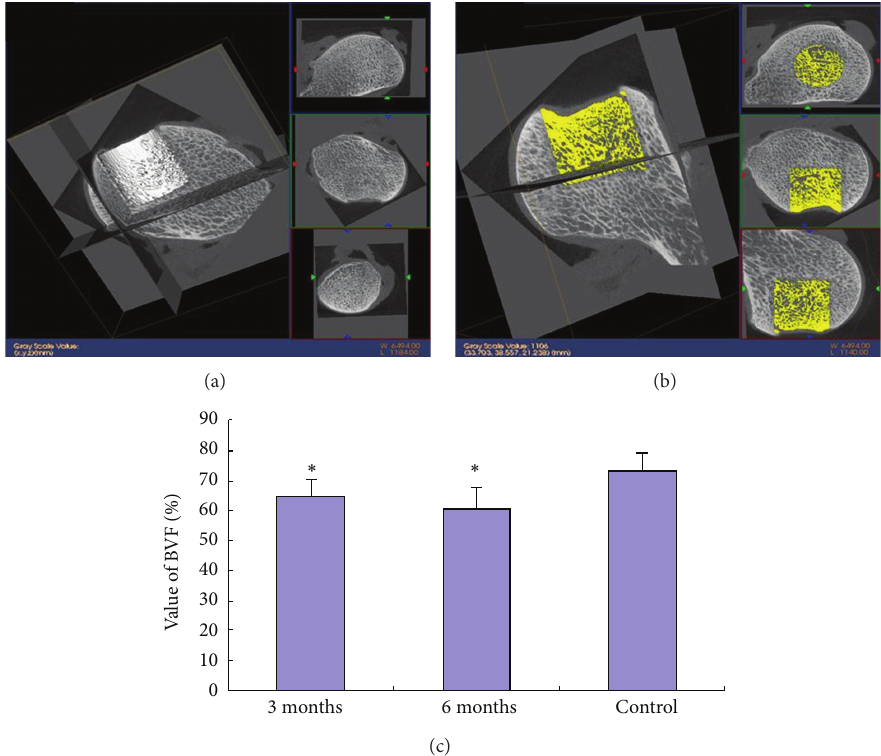
Figure 9: Micro-CT analysis: micro-CT images of implantation in (a) defective femoral head at 3 months and (b) defective femoral head at 6 months; (c) percentage of bone volume fraction (BVF) (%) at 3 and 6 months after repair of femoral head. ∗ 𝑃 < 0.05 compared with the control.